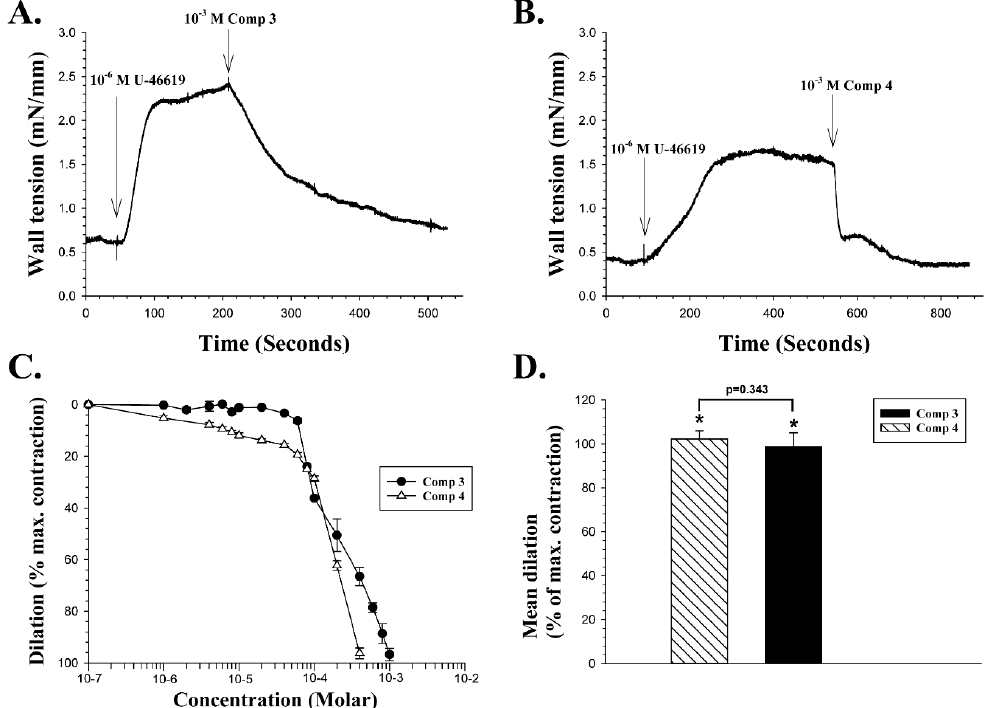
Figure 3. The effects of U-46619 and compounds 3 and 4 on retinal arterial wall tension. A : Continuous recording of wall tension. First, 10 − 6 M U-46619 was added to the bath, and when the vasoconstriction reached a peak in the experiment shown, a single dose of 10 − 3 M of compound 3 was added at the point indicated by the right vertical arrow. B : Continuous recording of wall tension from another vessel. At the peak of vasoconstriction induced by U-46619, a dose of 10 − 3 M of compound 4 was added at the point indicated by the right arrow. C : Mean concentration-response curves for the dilatory effects of compounds 3 (filled circles) and 4 (open triangles), expressed as a percentage of U-46619 induced maximum contraction. D : The mean dilation induced by compounds 3 and 4 in response to a single dose of 10 − 3 M added to the bathing solution, as a percentage of the maximum contraction induced by U-46619. An asterix (*) above a bar indicates statistically significant vasodilation ( p < 0.01 and p < 0.002).